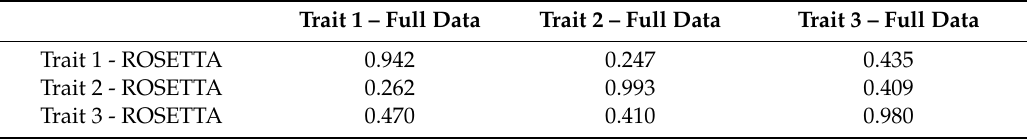
Table 2. Study 1: Observed Correlations between ROSETTA and Full Data.